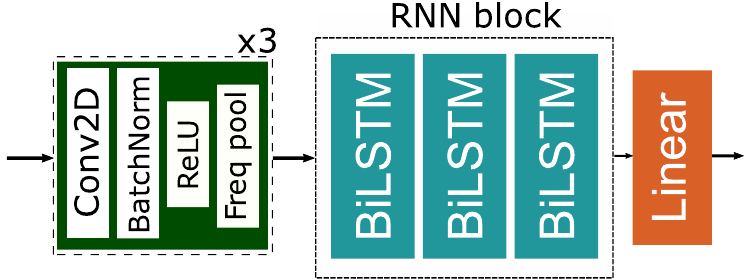
Figure 3. Convolutional recurrent neural network model proposed for the SAD